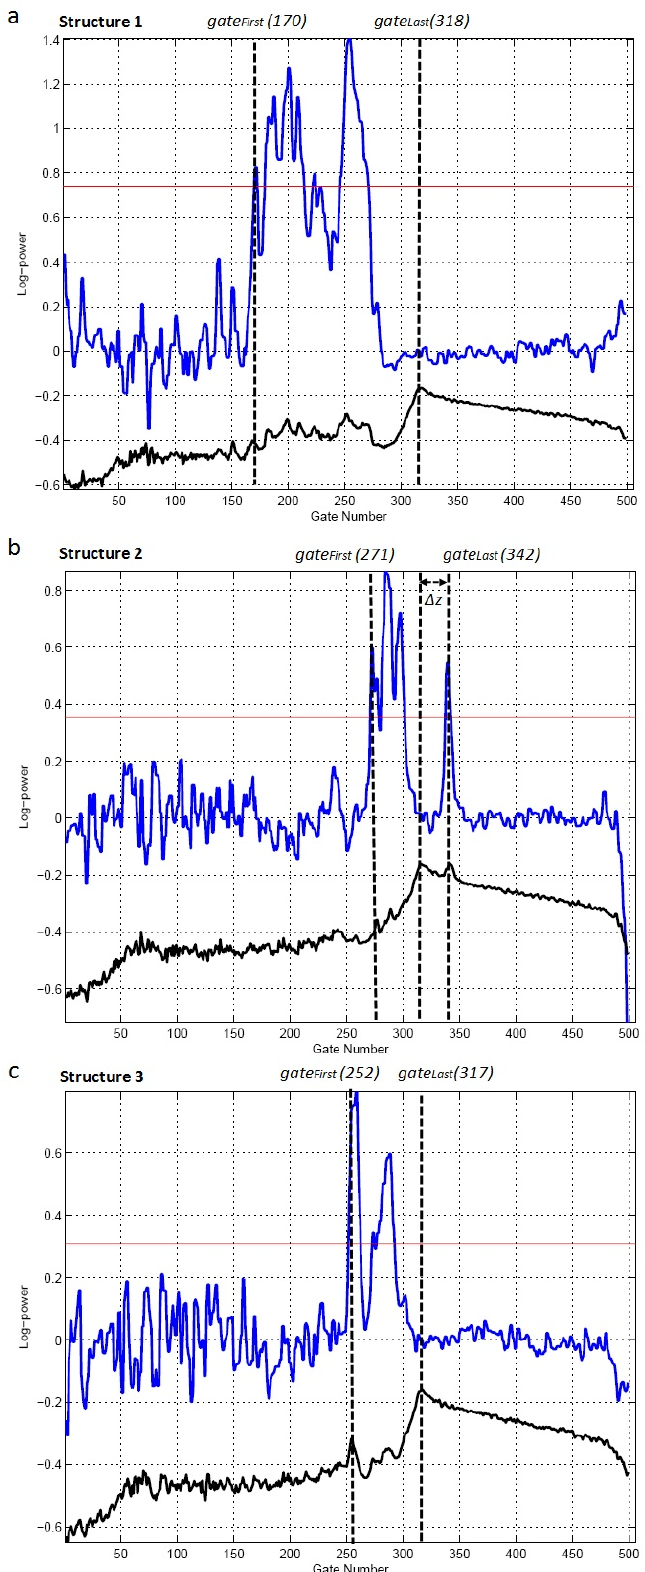
Figure 6. Plot of the averaged and filtered residuals (in blue) for the structures ( a ) 1; ( b ) 2; and ( c ) 3; respectively. The applied threshold is shown as a red line. The plot in black shows a corresponding waveform (in (cid:2869) log 10 scale), to determine the bin assigned to the peak of the ocean